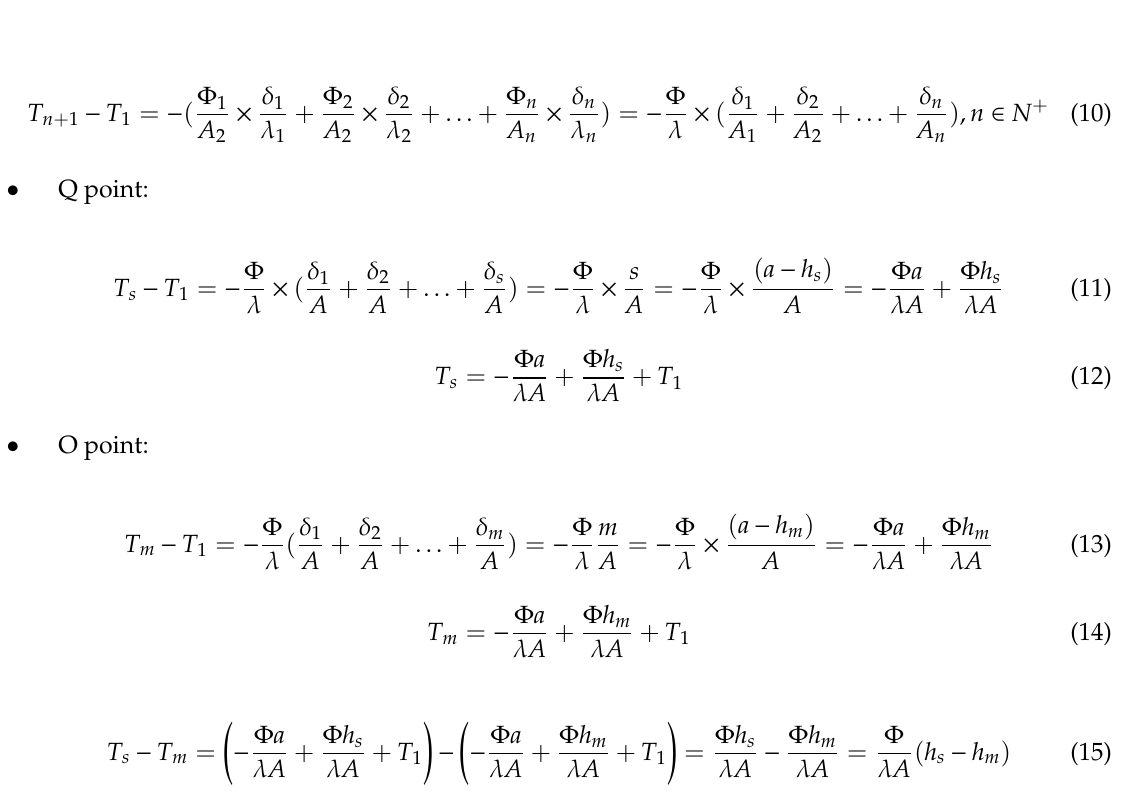
Figure 14. Dimensions of cracks on the LMD specimen.